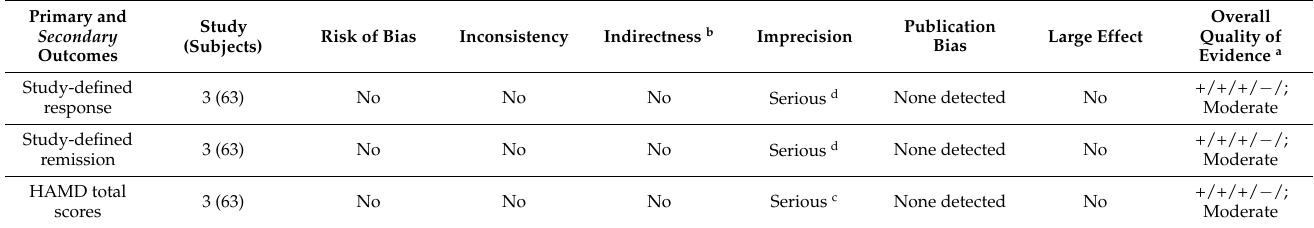
Table 2. GRADE analyses: MST versus ECT for depression.